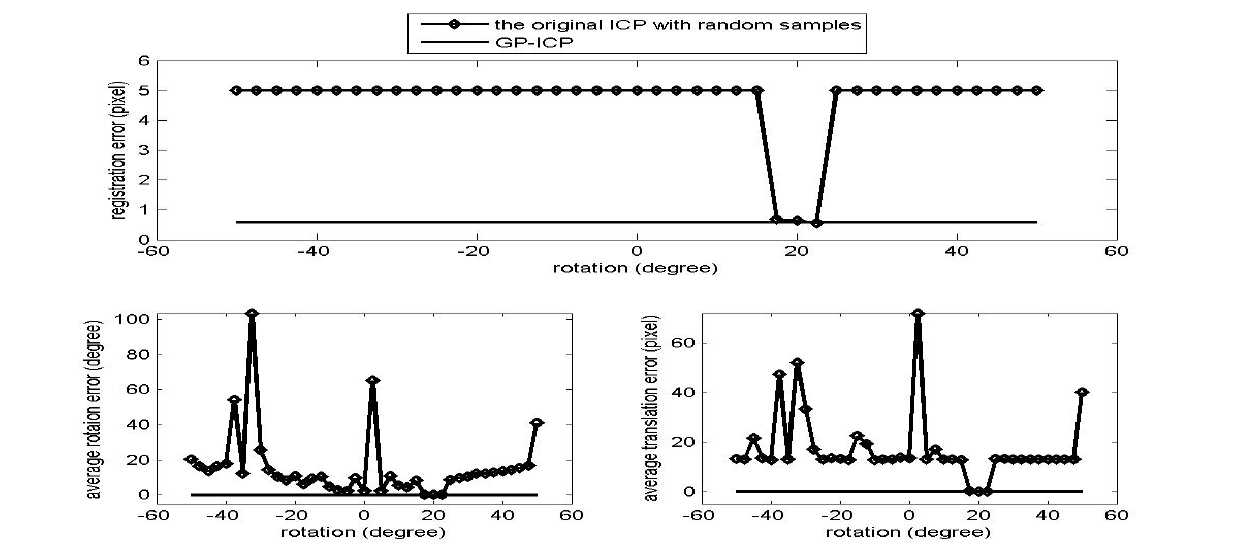
Figure 2. Convergence region test of the point clouds from the cactus with a translation, the translation 1, i.e. (H/4, L/4,